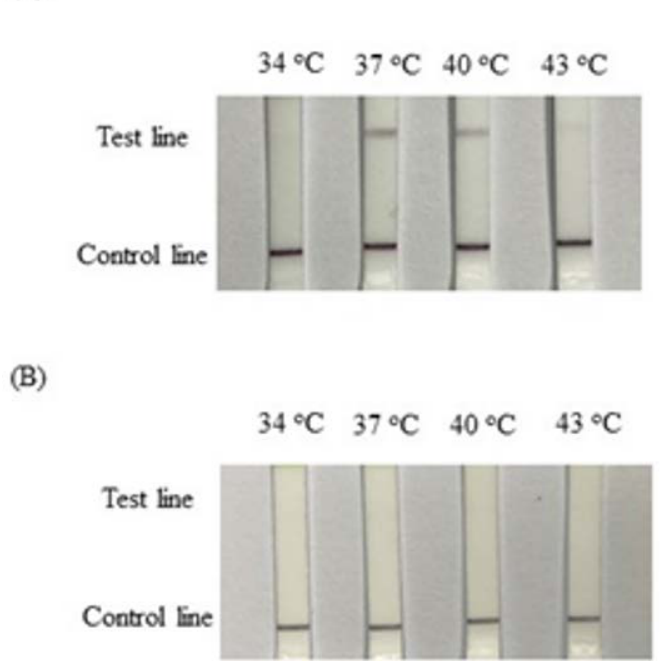
Figure 2. Optimization of the RPA-LFD reaction performed at different temperatures. ( A ) Reactions containing 0.1 ng/ µ L of genomic DNA from a female pigeon performed at different temperatures for 20 min. ( B ) Reactions containing 0.1 ng/ µ L of genomic DNA from a male pigeon performed at different temperatures for 20